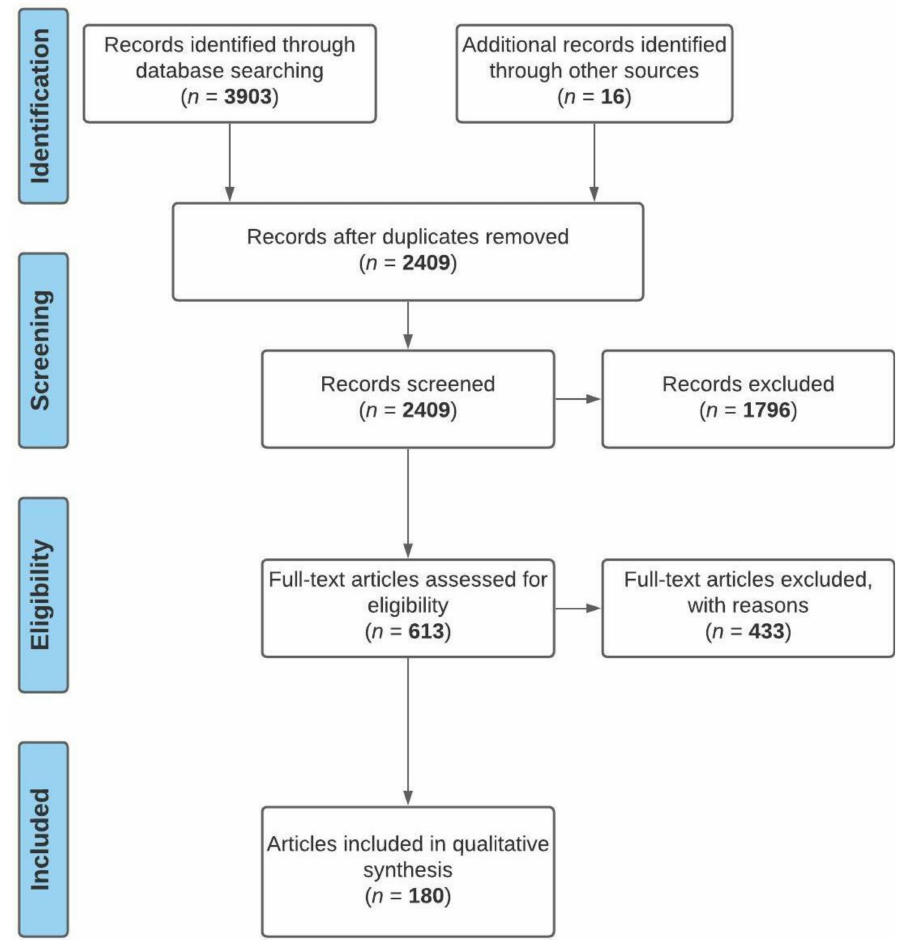
Figure 1. PRISMA protocol for screening relevant